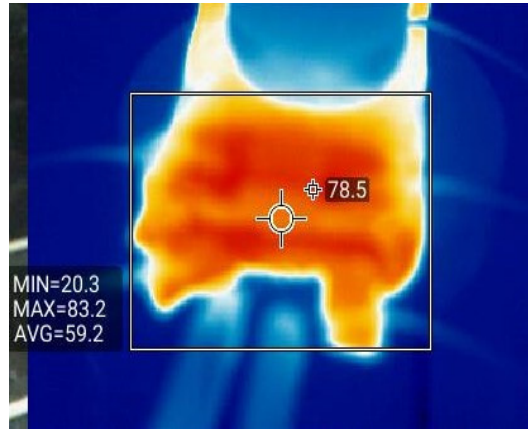
Figure 11. Thermal imaging images.